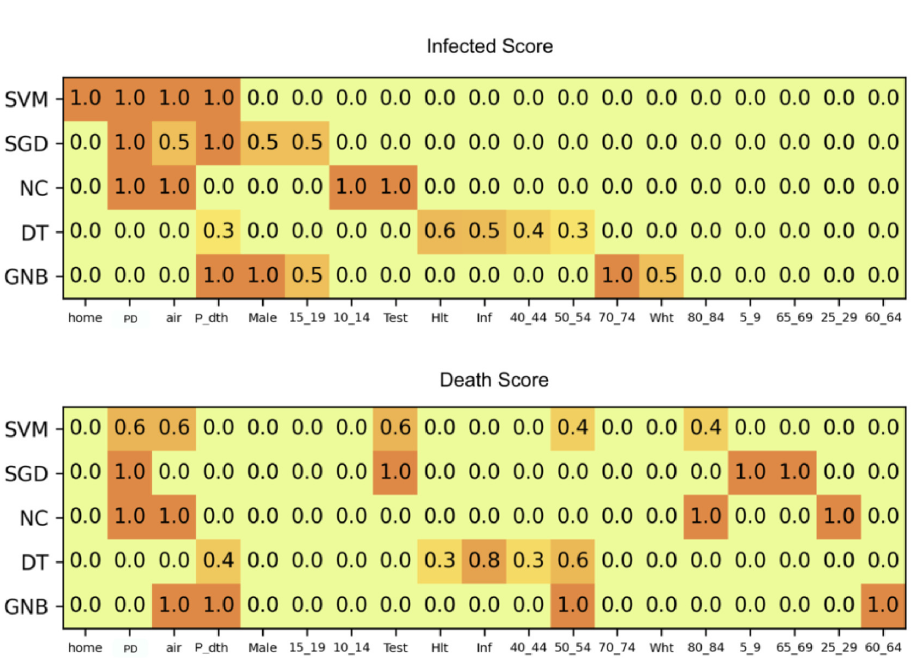
PLOS ONE | https://doi.org/10.1371/journal.pone.0241165 October 23,